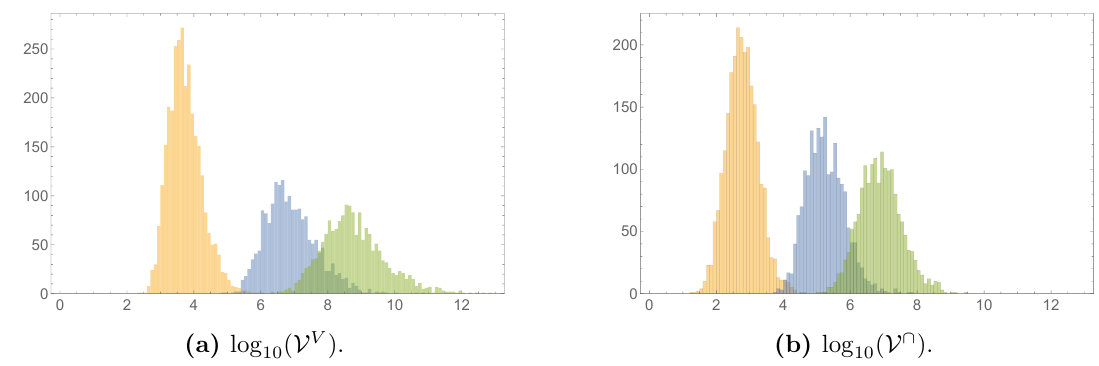
Figure 9. Lower bounds on V in g K V (left) and f K \ (right) for h 1 ; 1 = 10 (leftmost peak), 30 (center peak), and 50 (rightmost